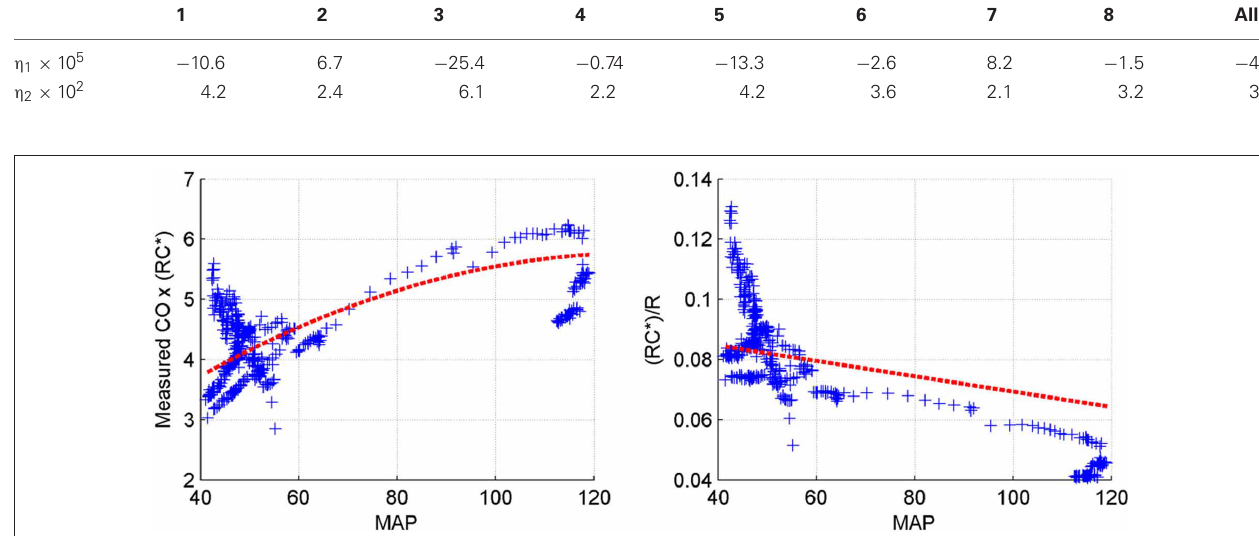
FIGURE 3 | Validity of linear pressure-dependent arterial compliance model (Subject